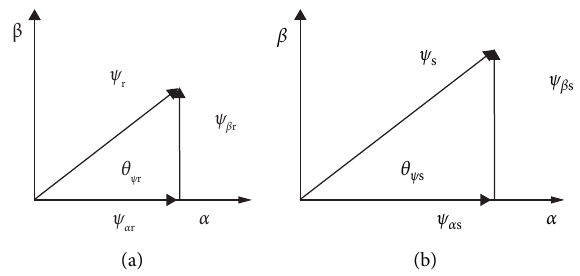
Figure 1: Phasor diagram for rotor and stator fux